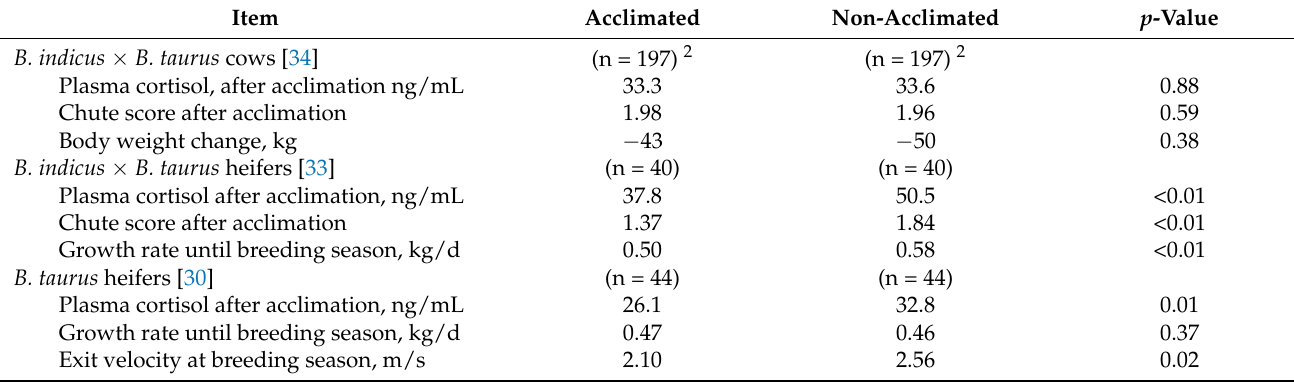
Table 3. Effects of acclimation to human handling on temperament and productive traits of beef cattle [4,30,33,34] 1 .